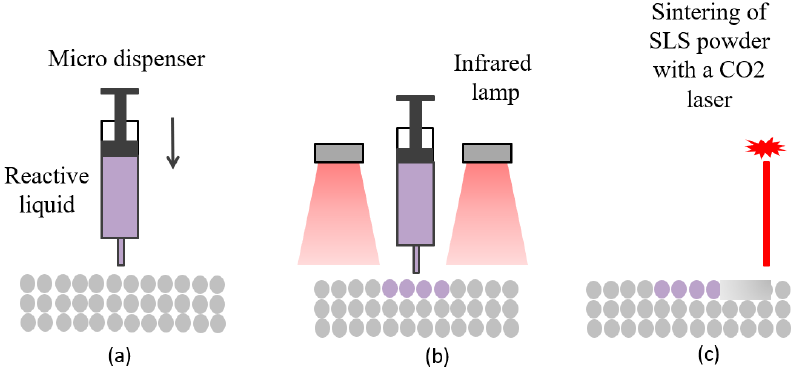
Figure 3. Scheme of the hybrid selective laser sintering (SLS) process. ( a ) Fluid material is injected to SLS powder bed; ( b ) curing reaction of the liquid initiated via IR radiation; ( c ) SLS powders are melted with a CO 2 laser.